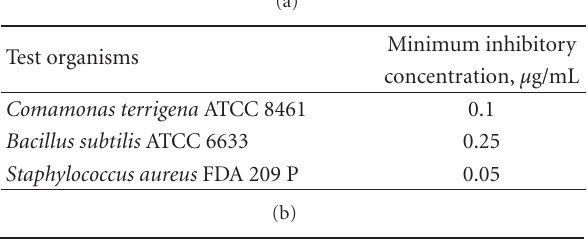
Table 1: (a) Antimicrobial activity of antibiotic no. 70. (b) Antimi- crobial activity of antibiotic no. 70 against clinical